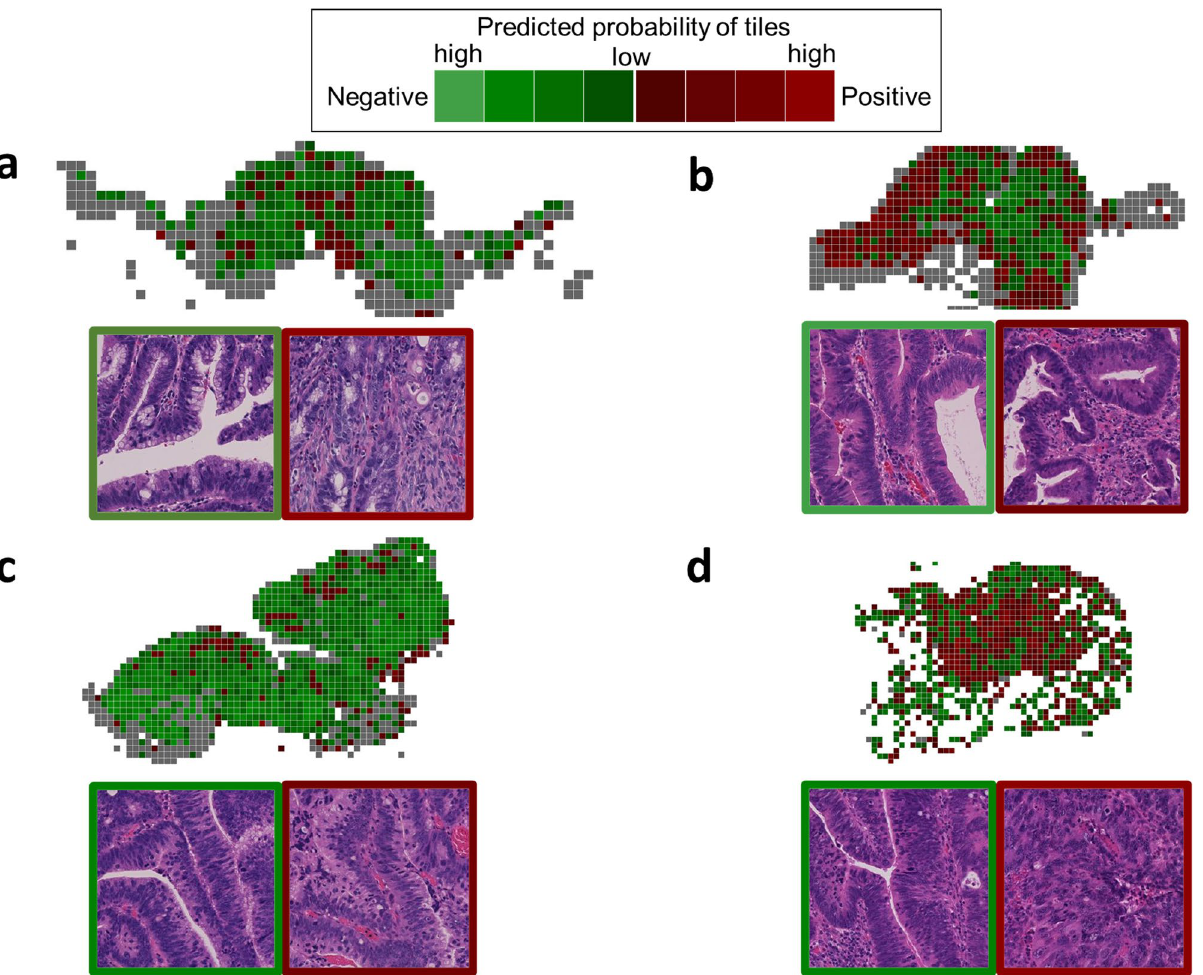
Figure 3. Four representative validation cases. Color mapping of tiles and representative tile images are shown. ( a ) LNM negative case with RF score of 0.0000, ( b ) LNM negative case with RF score of 0.9117, ( c ) LNM positive case with RF score of 0.0001, ( d ) LNM positive case with RF score of 0.9143. The red tiles correspond to positive predicted, and green tiles correspond to negative predicted. The color brightness represents the probability of each tile: the brighter the tile, the higher the probability. Gray tiles are classified as non-tumor by classifier #1. Scales: 1 tile equals to 273-µm